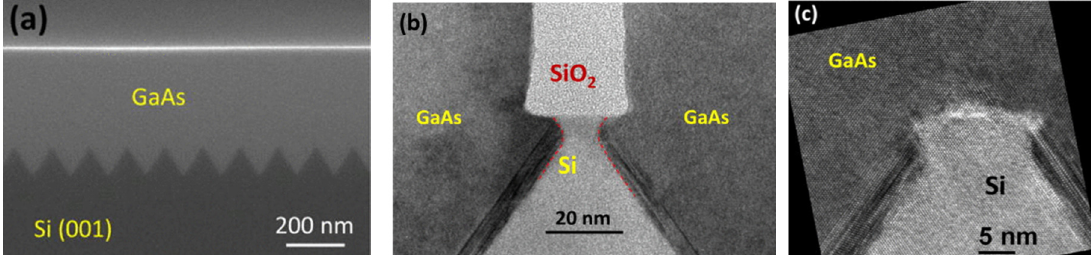
Figure 3. Schematic illustration of capability for trapping threading dislocations (TDs) and APBs in aspect ratio trapping (ART) technique. Reprinted with permission from Reference [24] © 2017 Elsevier, Ltd.